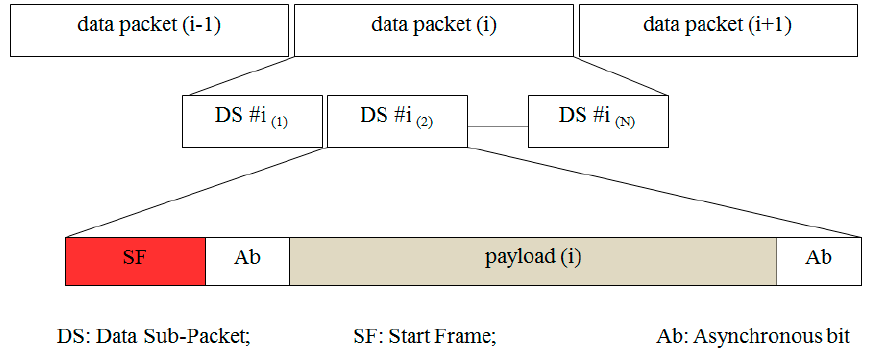
Figure 4. Proposed data frame structure #1 for ISC between rolling shutter camera and LED. A data packet consists of multiple sub-packets which bring the same payload.